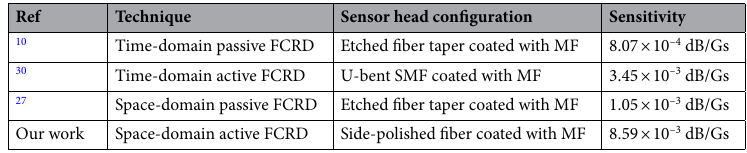
Table 1. Comparison with conventional FCRD techniques.